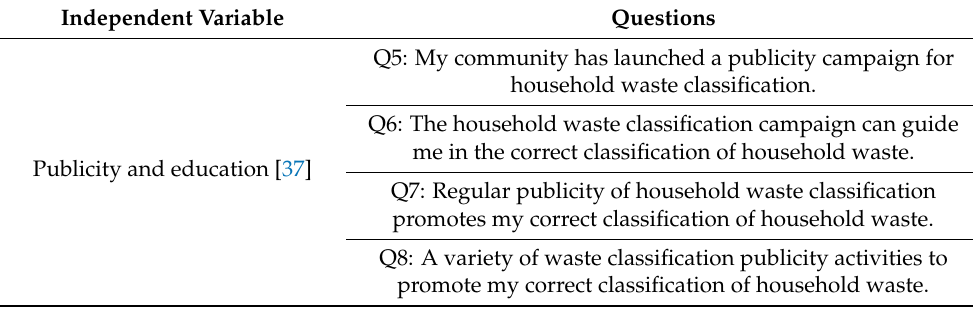
Table 1. Publicity and education questions.